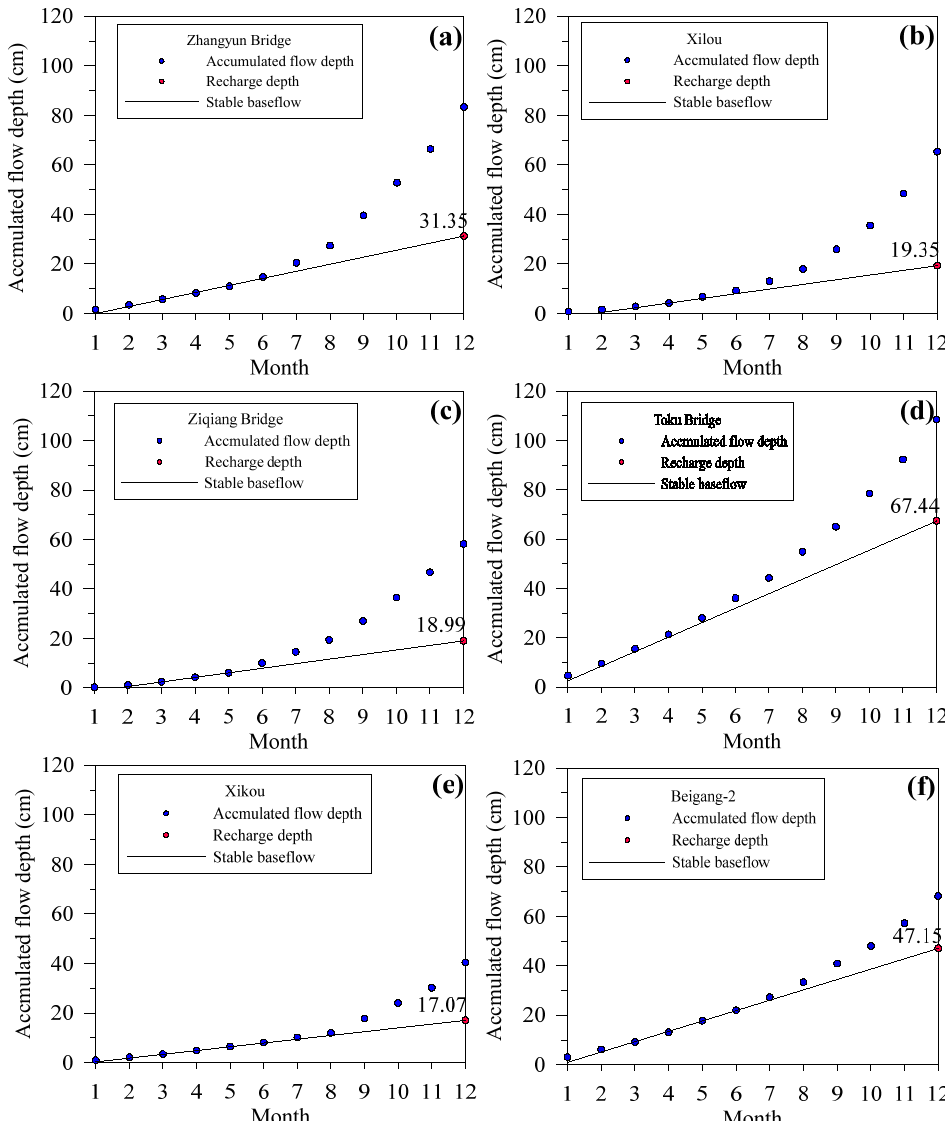
Figure 7. Results of stable baseflow analysis for ( a ) Zhangyun Bridge, ( b ) Xiluo, ( c ) Ziqiang Bridge, ( d ) Tuku Bridge, ( e ) Xikou, and ( f ) Beigang-2 in the Choushui River alluvial fan.